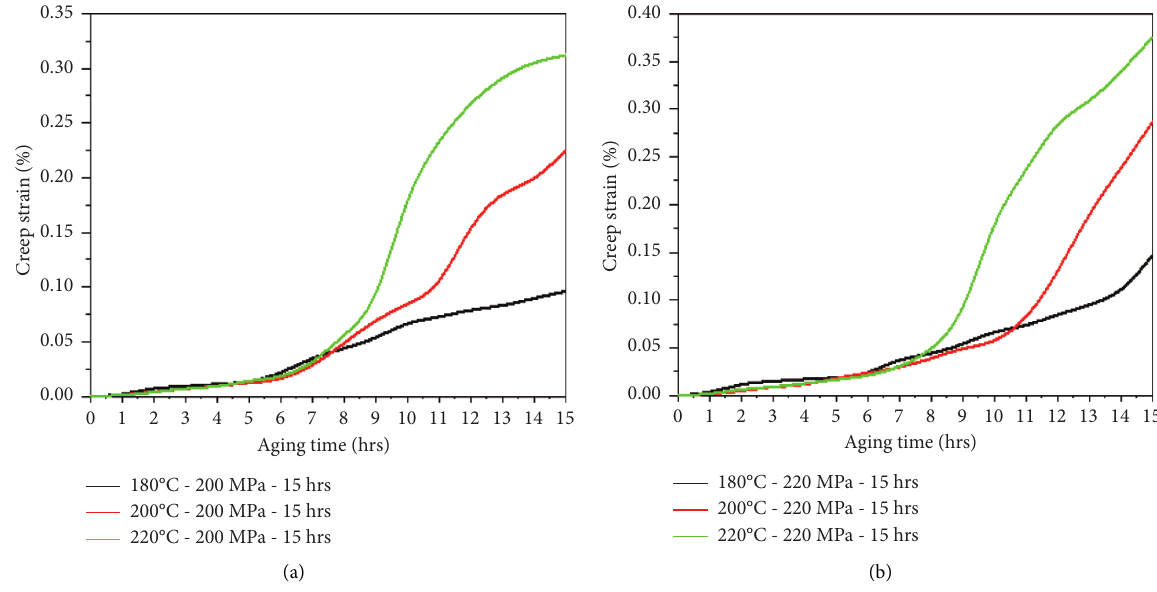
Figure 4: (a) Creep aging graph, aging time vs. creep strain (200MPa). (b) Creep aging graph, aging time vs. creep strain (220